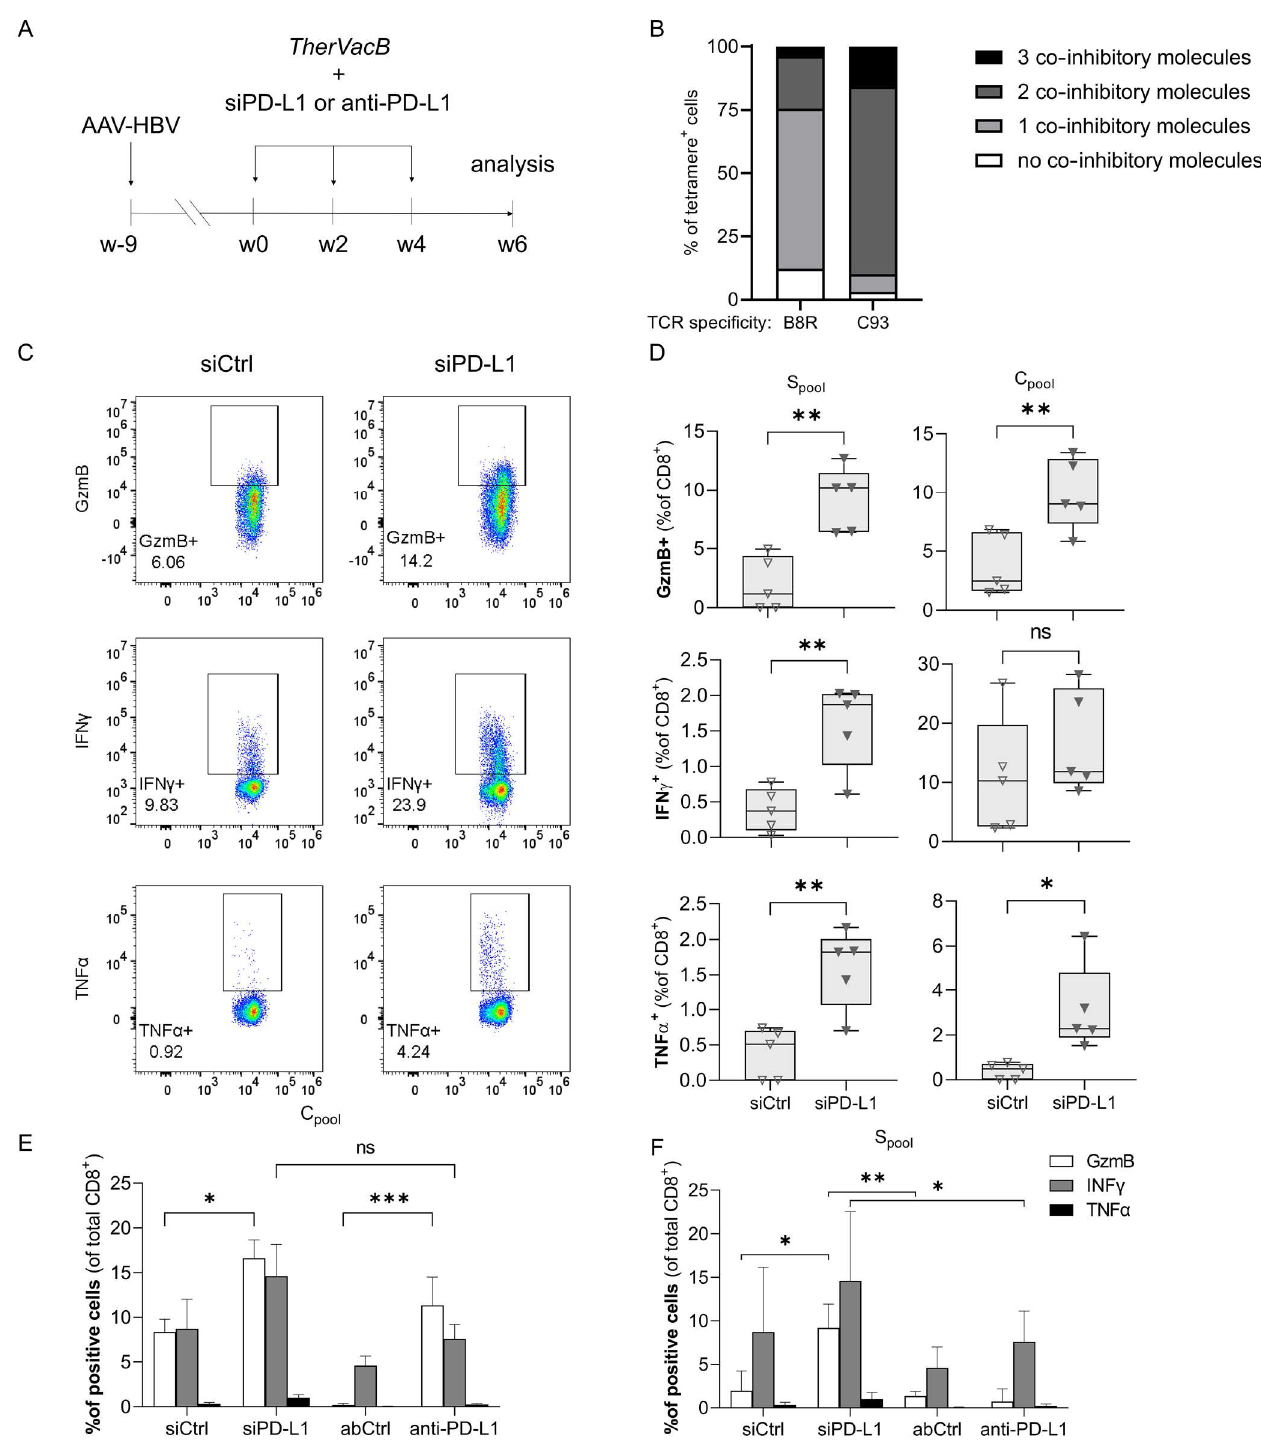
Figure 1. Effect of PD-L1 checkpoint blockade on functionality of HBV-specific T cells. ( A ) C57Bl/6J mice ( n = 5 per group) were infected intravenously with AAV-HBV resulting in persistent HBV replication. After nine weeks, mice were vaccinated two times using a combination of HBc and HBsAg adjuvanted with c-di-AMP (week 0 and week 2), and one time using an MVA expressing HBV core and S (week 4). Either 1 mg/kg siRNA or 100 µg antibody was administered i.v. one day prior to each vaccination. Mice were sacrificed at week 6. ( B ) HBV-specific (C 93 ) and MVA-specific (B8R) liver-associated lymphocytes (LAL) identified by multimer staining were co-stained for PD- 1, TIM3 and LAG-3. The percentage of cells expressing one or more of these markers is indicated.